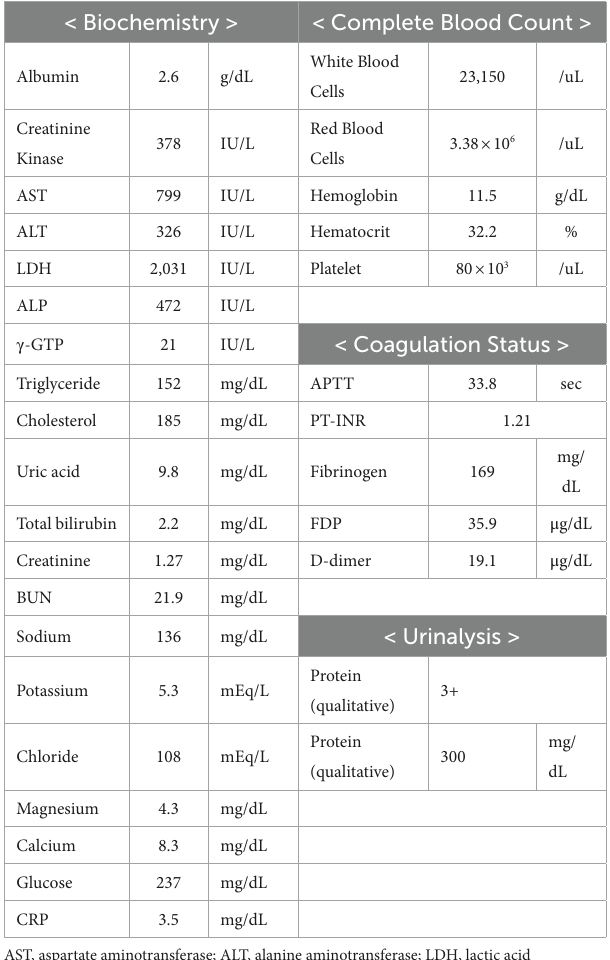
TABLE 1 Laboratory findings on